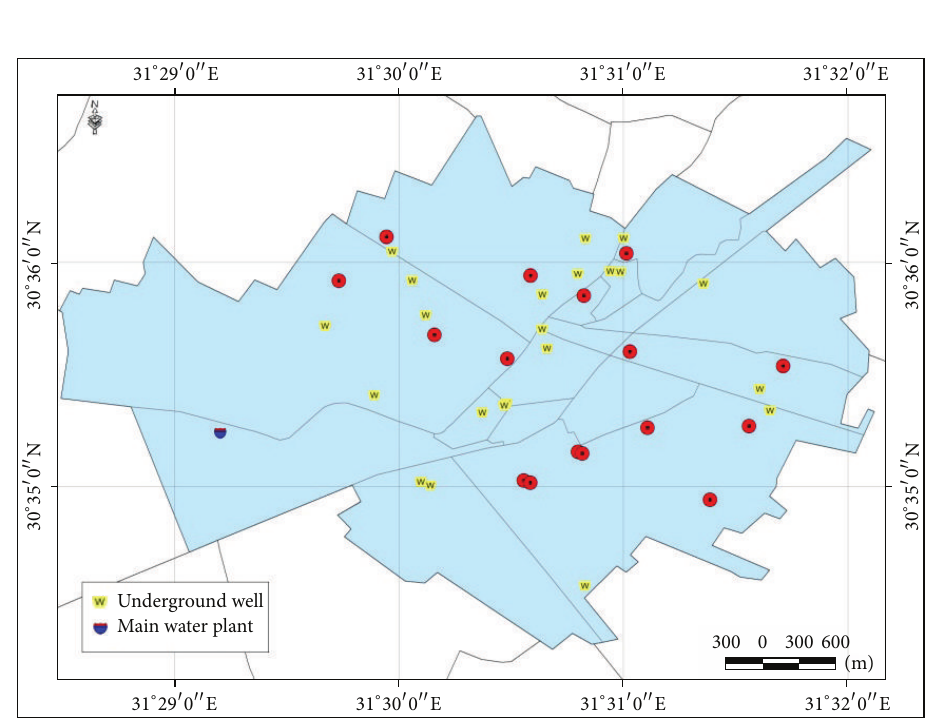
Figure 3: The positive E . coli isolates in relation to water sources in different regions of